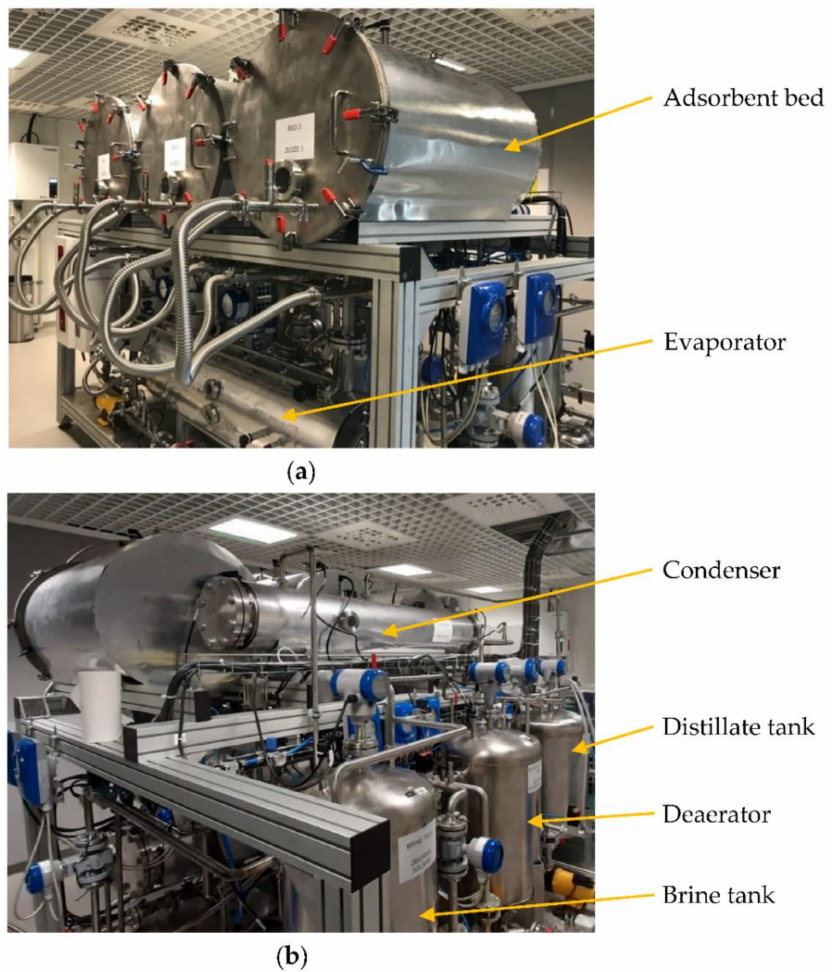
Figure 3. Pictures of the test stand: ( a ) view of evaporator and adsorption bed; ( b ) view of the condenser, distillate tank, deaerator tank, and brine